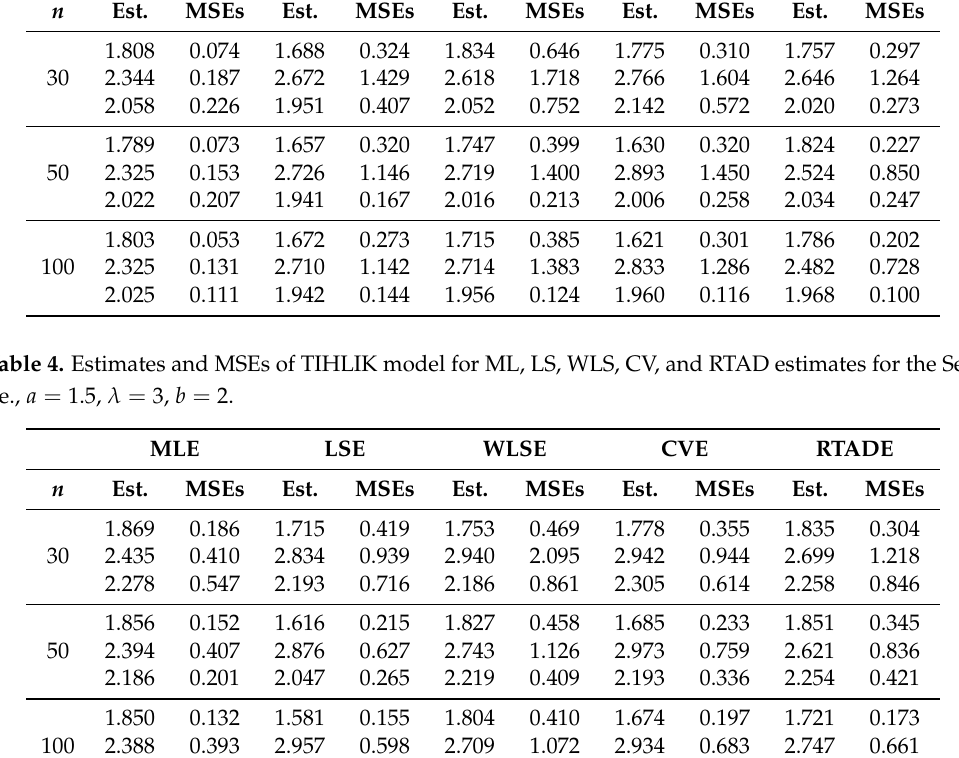
Table 3. Estimates and MSEs of TIHLIK model for ML, LS, WLS, CV, and RTAD estimates for the Set2, i.e., a = 2, λ = 2, b = 2. MLE LSE WLSE CVE RTADE